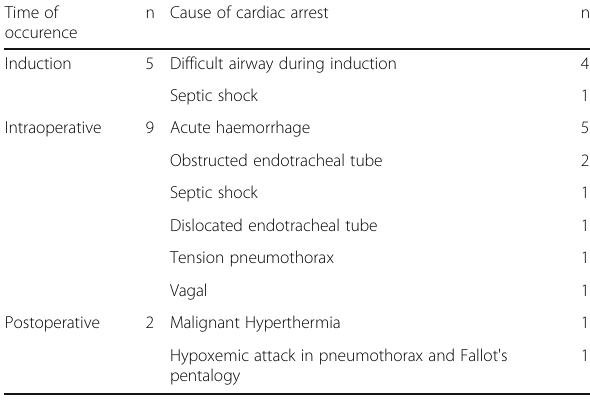
Table 1 (abstract 000227). See text for description Table 1 (abstract 000231). Characteristics of perioperative paediatric cardiac arrests